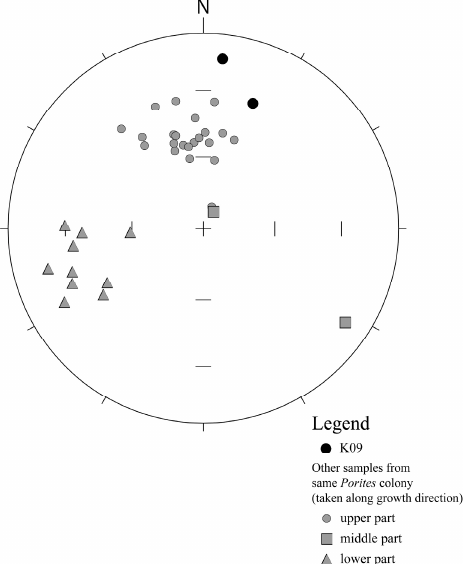
Figure A2. Stereographic projection diagram for characteristic remanent magnetization (ChRM) direction of subsamples from Porites colony at Ibaruma. Directions of ChRM are calculated by PCR method [34] using Puffinplot software [35]. Black circles indicate K09 subsamples (vector plots are shown as Figure A1). It is also shown ChRM results from other subsamples continuously taken along the growth direction of Porites colony (NRM was measured using superconducting rock magnetometer in AIST). Gray circles, squares, and triangles indicate upper part, middle part, lower part of growth direction, respectively. Results of the upper part cluster around the north and those of the lower part cluster around the west direction. This figure is generated using PMAGTOOL [36].